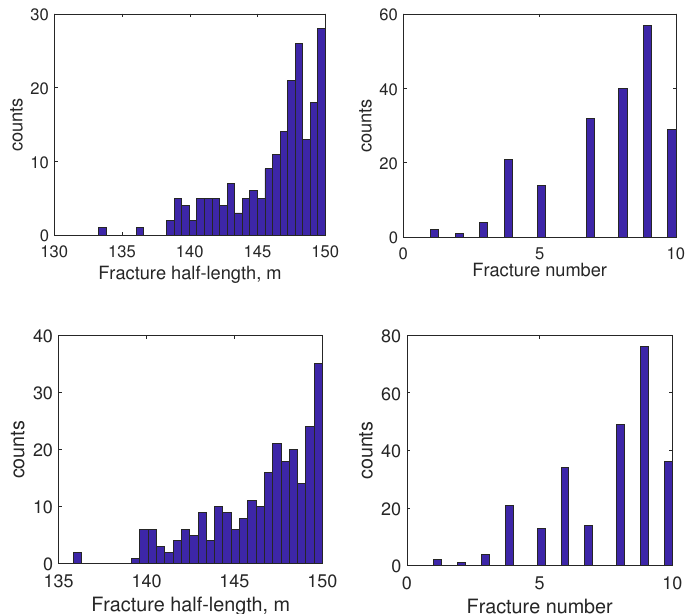
Figure 17. Distributions of optimized hydraulic fracturing parameters with respect to the number of iteration steps. The subfigures from top to the down position are corresponding to 100, 200, 300, 400 and 500 iteration